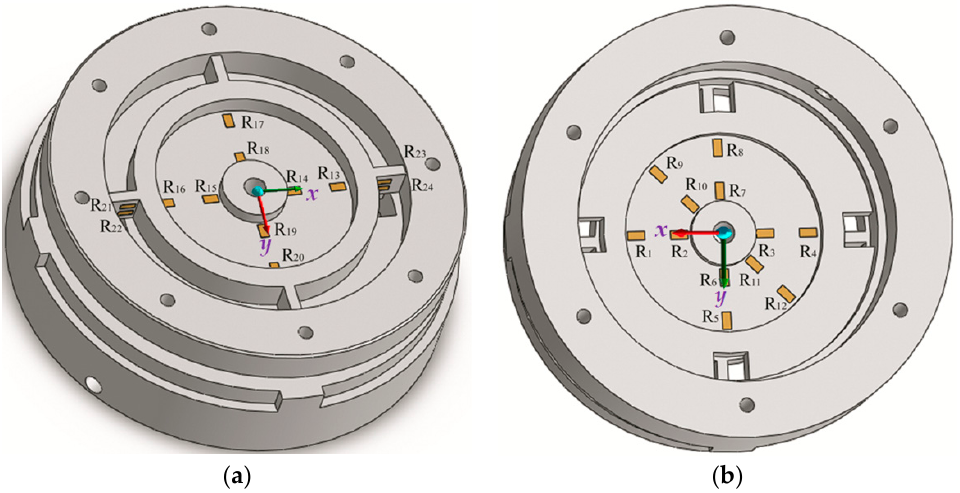
Figure 9. Arrangement strategy of the strain gauges: ( a ) Gauges emplacement on the upper diaphragm; ( b ) Gauges emplacement on the lower diaphragm.